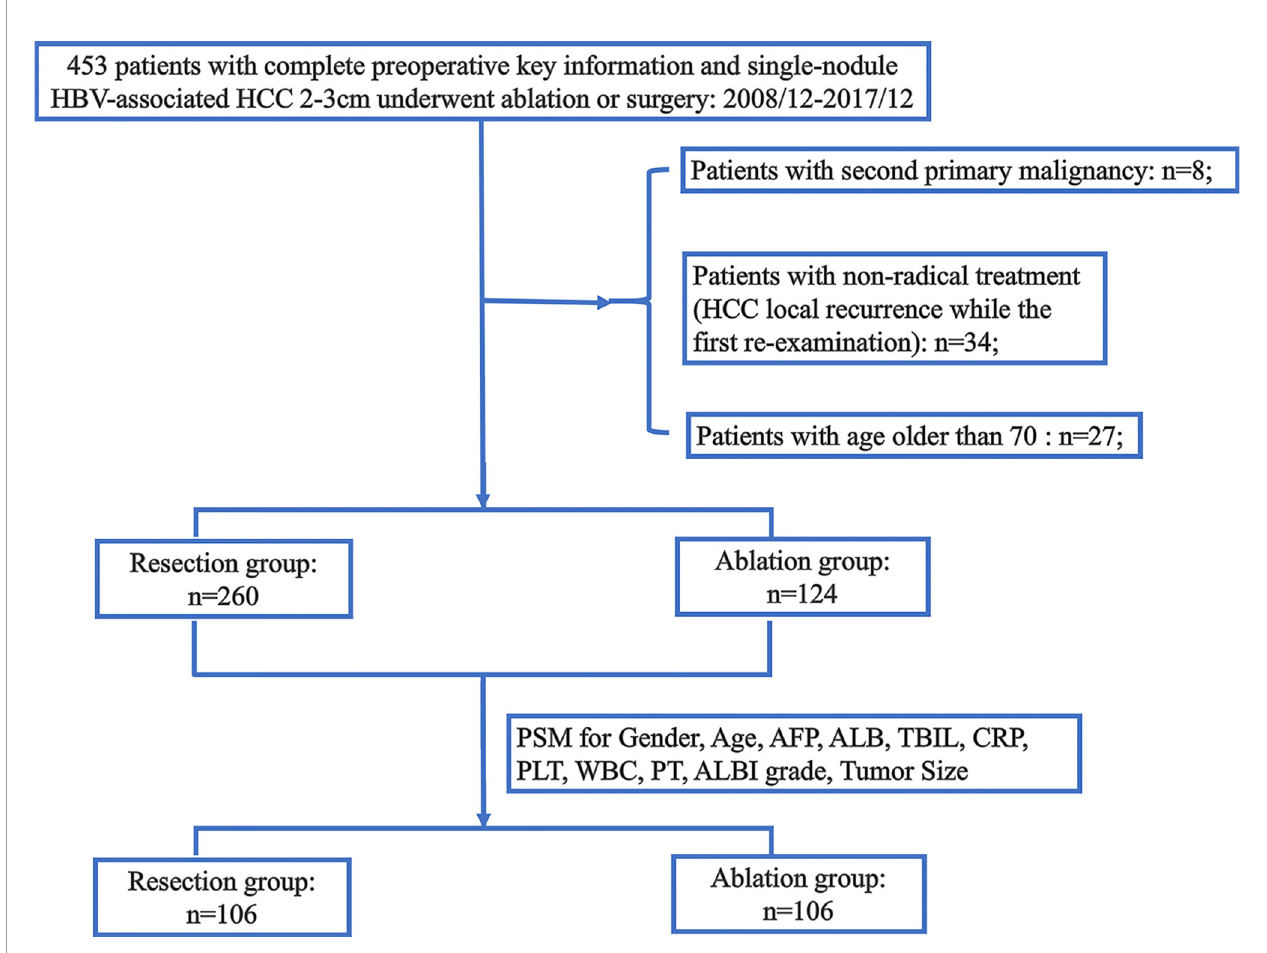
FIGURE 1 | The fl owchart of the selection. HCC, hepatocellular carcinoma; HBV, hepatitis B virus; AFP, alpha-fetoprotein; ALB, albumin; TBIL, total bilirubin; CRP, C-reactive protein; PLT, platelet; WBC, white blood cell; PT, prothrombin time; ALBI, albumin – bilirubin; PSM, propensity score